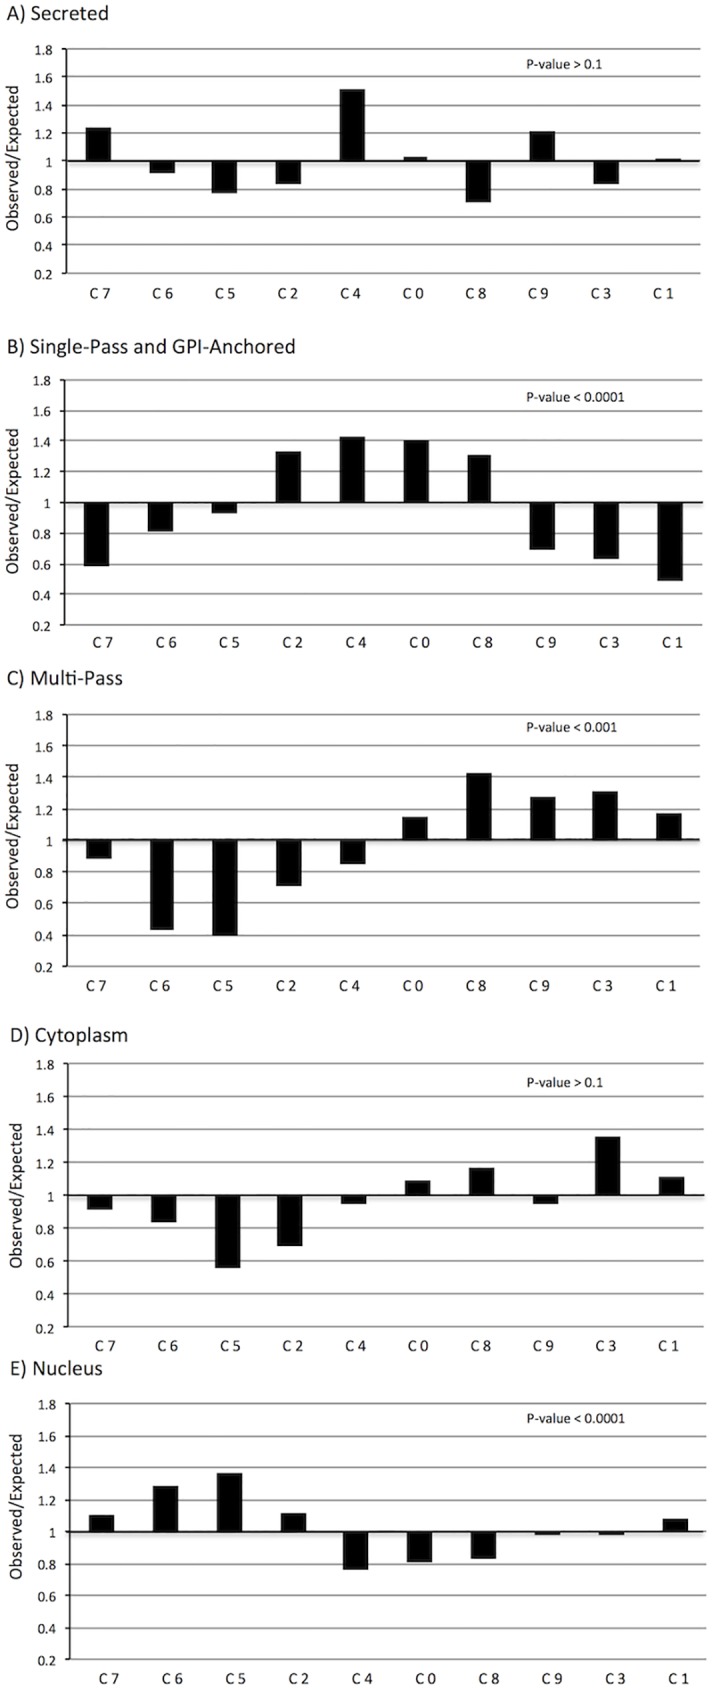
Enrichment of protein localisation categories across clusters.Relative enrichment across clusters is shown by plotting observed/expected numbers of proteins per cluster for each of five groups: secreted proteins (A), single-pass transmembrane or GPI-anchored proteins (B), multi-pass transmembrane proteins (C), cytoplasmic proteins (D) and nuclear proteins (E). A value of 1 indicates observed data matches expected values, whereas a value below or above 1 indicates decreased or increased counts compared to expected values, respectively. The ten clusters (C0-C9) are organized according to age of peak expression, as in Fig 6. P-values from chi square analyses are shown in upper right corner of each graph. Genes encoding nuclear proteins are enriched in clusters defined by strong early embryonic expression, single-pass transmembrane and GPI-linked protein-encoding genes are enriched in clusters expressed at mid-embryonic stages and multi-pass transmembrane proteins are enriched in clusters expressed at postnatal stages.